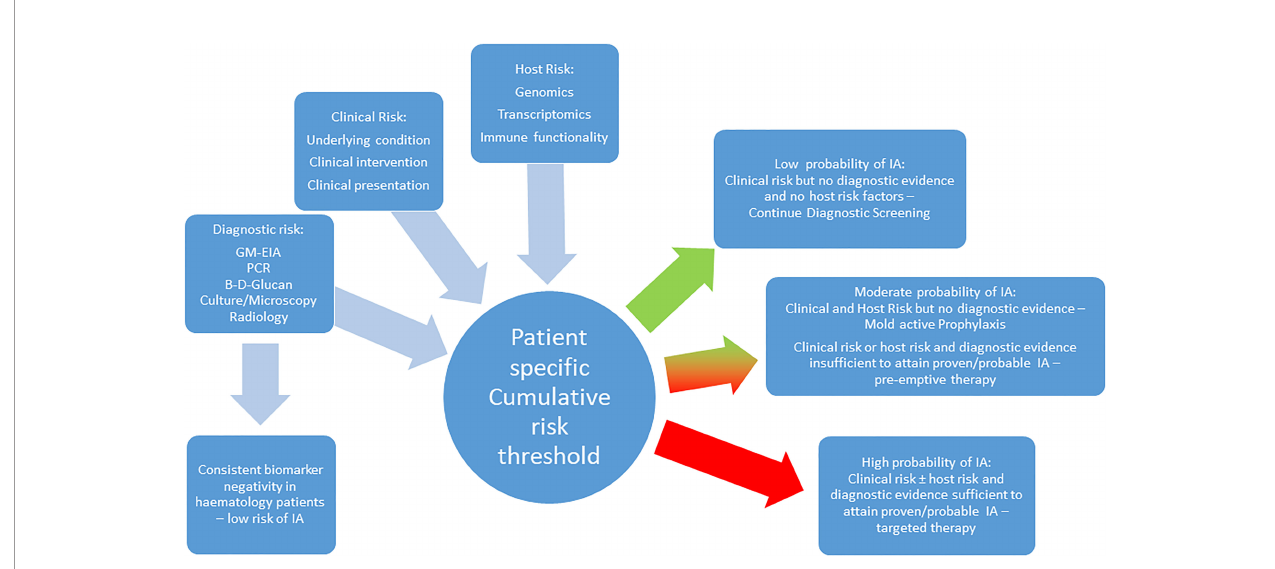
FIGURE 1 | A proposed combined strategy incorporating clinical, host and diagnostic risk for managing the risk of IA in the hematology